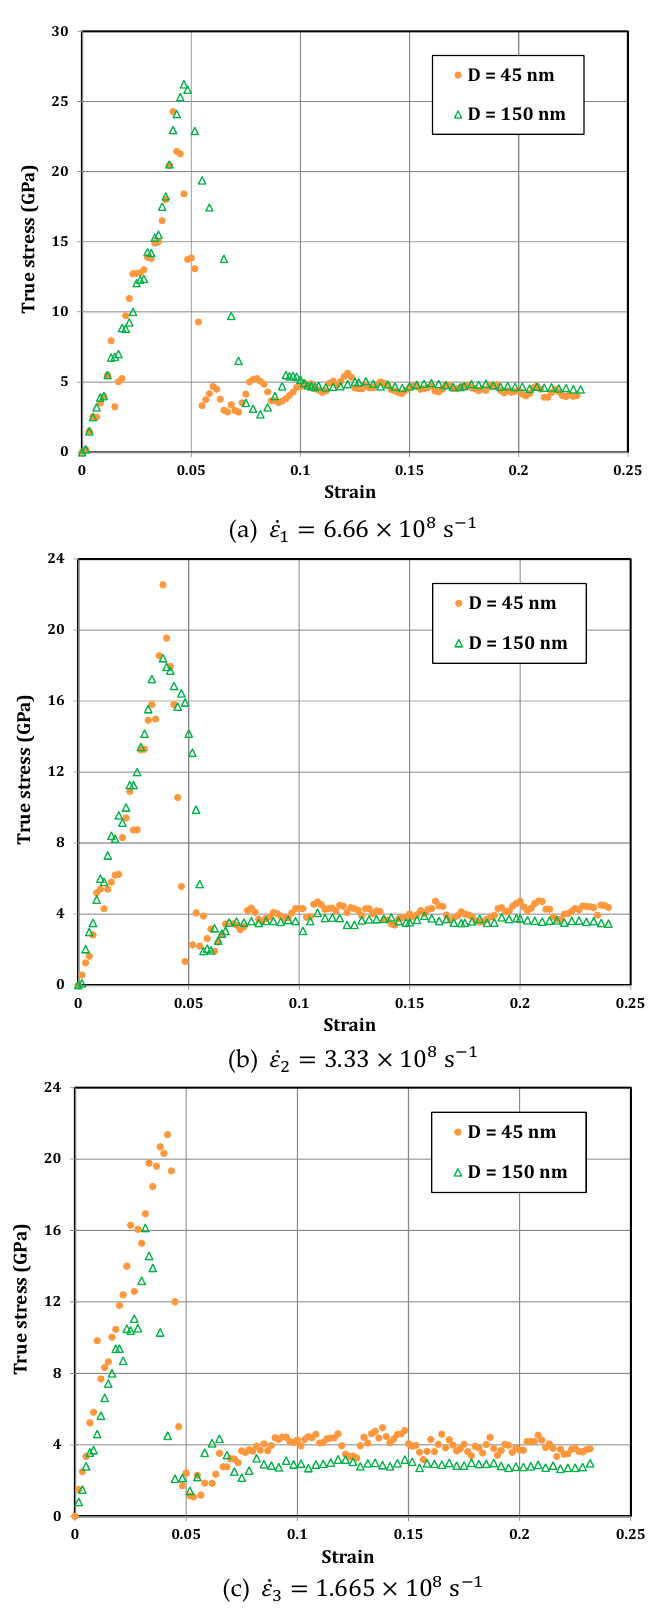
Figure 23. The responses of pillars with D = 45 nm and D = 150 nm during micropillar compression test with different strain rates of: ( a ) 𝜀(cid:4662) (cid:2869) = 6.66 × 10 (cid:2876) s (cid:2879)(cid:2869) ; ( b ) 𝜀(cid:4662) (cid:2870) = 3.33 × 10 (cid:2876) s (cid:2879)(cid:2869) ; ( c ) 𝜀(cid:4662) (cid:2871) = 1.665 × 10 (cid:2876) s (cid:2879)(cid:2869) (after Voyiadjis and Yaghoobi [16]).